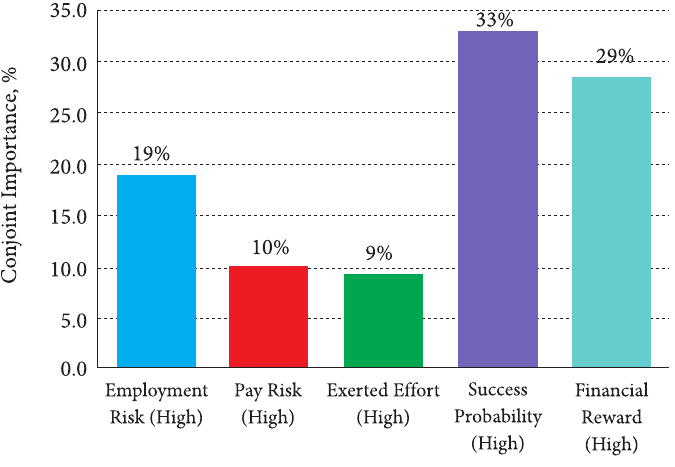
Fig. 4. Conjoint importances for each attribute